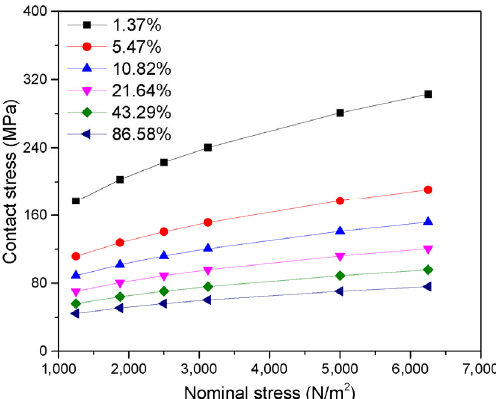
Fig. 11 The measurement of the contact stress varies with increasing nominal stress with different area ratio.